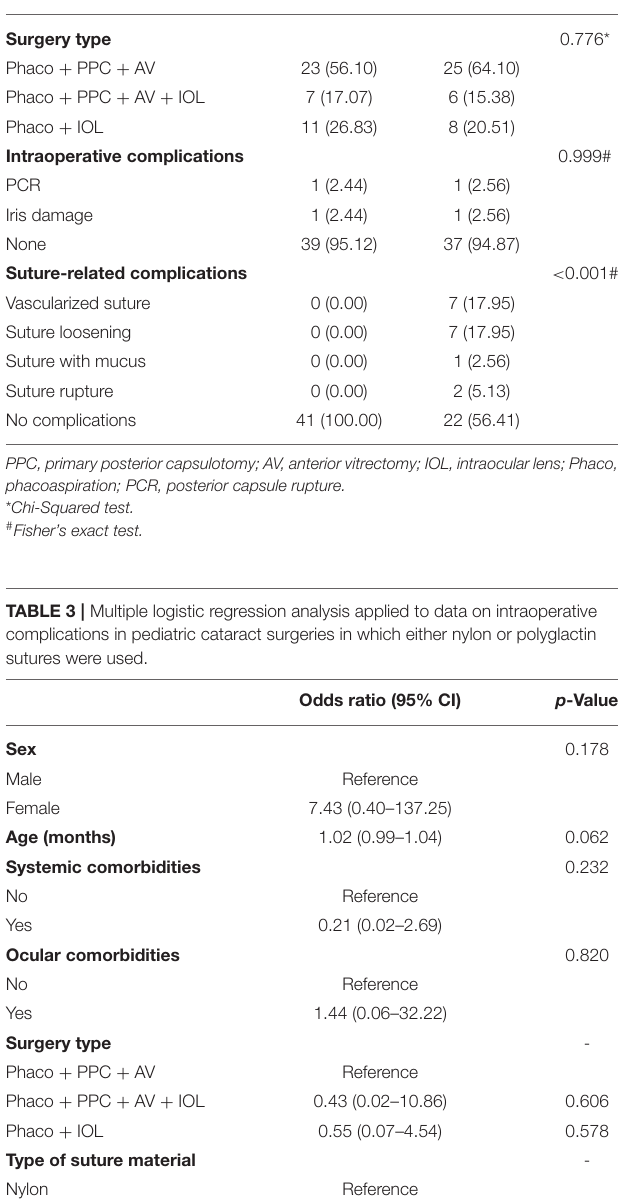
TABLE 2 | Pediatric cataract surgery outcomes organized by suture material used TABLE 1 | Demographic characteristics of pediatric cataract patients in the (polyglactin vs. nylon sutures). polyglactin suture group and the nylon suture group. Polyglactin Nylon group p -Value Polyglactin group Nylon group p -Value group